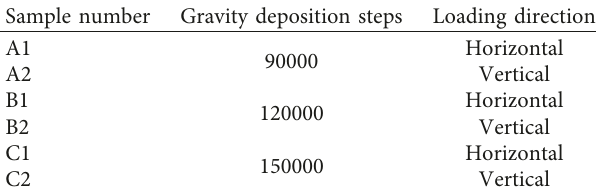
Table 5: List of samples and test